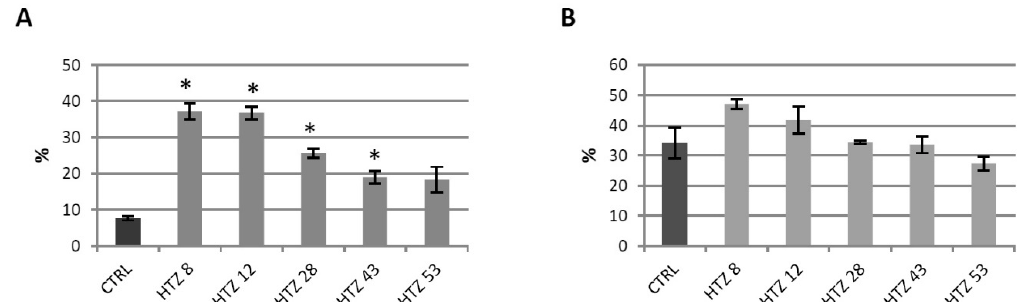
Figure 5. Antioxidant potential expressed as the percent of quenched 2,2-diphenyl-1-picrylhydrazyl (DPPH) radical measured in methanol extracts ( A ) and extracts after hydrolysis ( B ) from transgenic HTZ lines compared to the non-transgenic potato (CTRL), presented as the means of six biological replicates ± standard deviation. Statistically significant changes ( p < 0.05) are marked with asterisks.